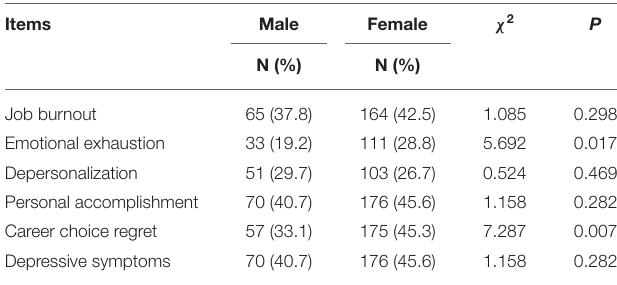
TABLE 1 | Demographic characteristics of participants. TABLE 2 | Prevalence comparison of job burnout, career choice regret, and depressive symptoms.